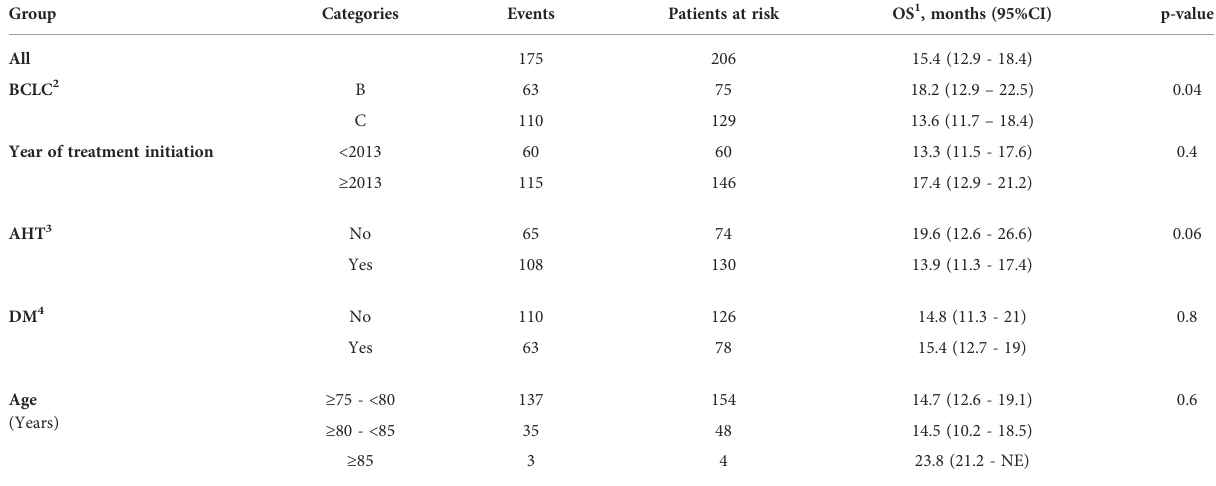
TABLE 5 Prognostic factors related to overall survival.